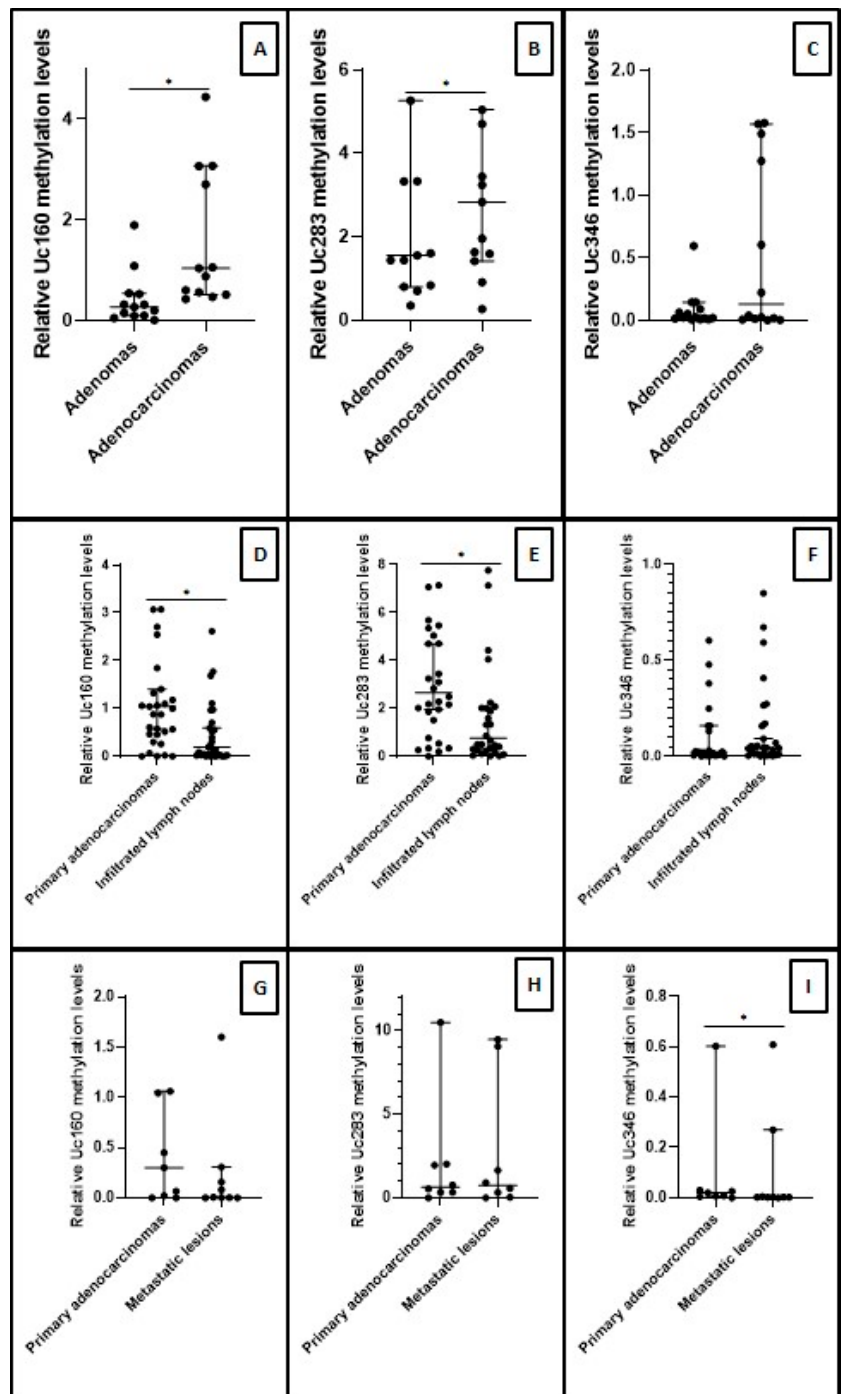
Figure 3. Relative tissue methylation levels of Uc160, Uc283, and Uc346 in primary tumors, in relation to paired adenomas, infiltrated lymph nodes, or metastatic lesions from the same patient. ( A – C ): methylation levels of Uc160 ( A ), Uc283 ( B ), and Uc346 ( C ) in adenomas and primary tumors; ( D – F ): methylation levels of Uc160 ( D ), Uc283 ( E ), and Uc346 ( F ) in primary tumors and infiltrated lymph nodes; and ( G – I ): methylation levels of Uc160 ( G ), Uc283 ( H ), and Uc346 ( I ) in primary tumors and metastatic lesions (median values with 95% CI).* p <